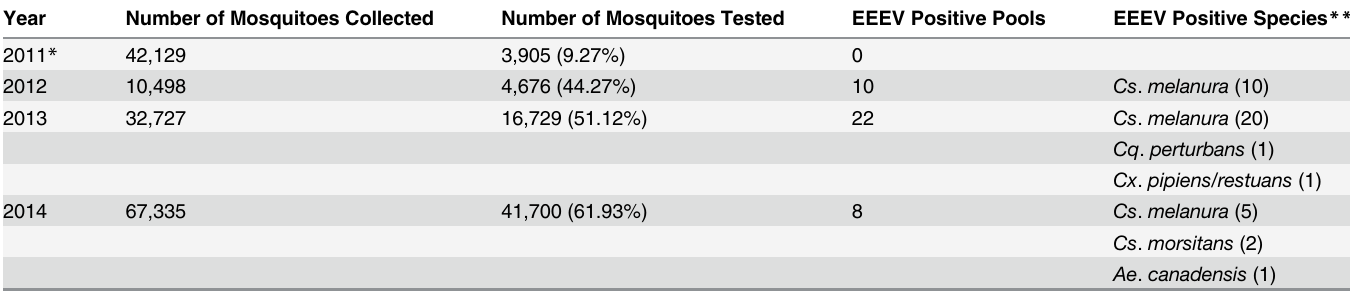
* Tested using the VecTest. 2012 – 2014 samples were tested using RT-PCR (27) ** Number in parenthesis indicates number of positive